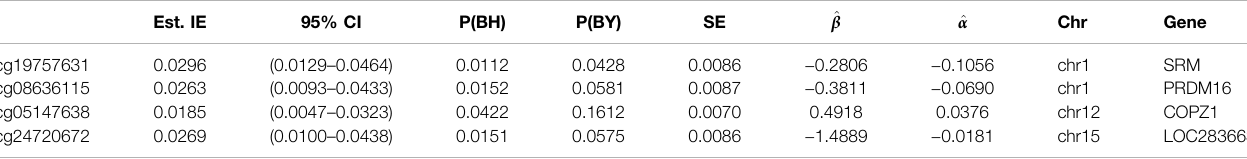
TABLE 3 | Signi fi cant mediate CpG sites with positive indirect effect. Est.